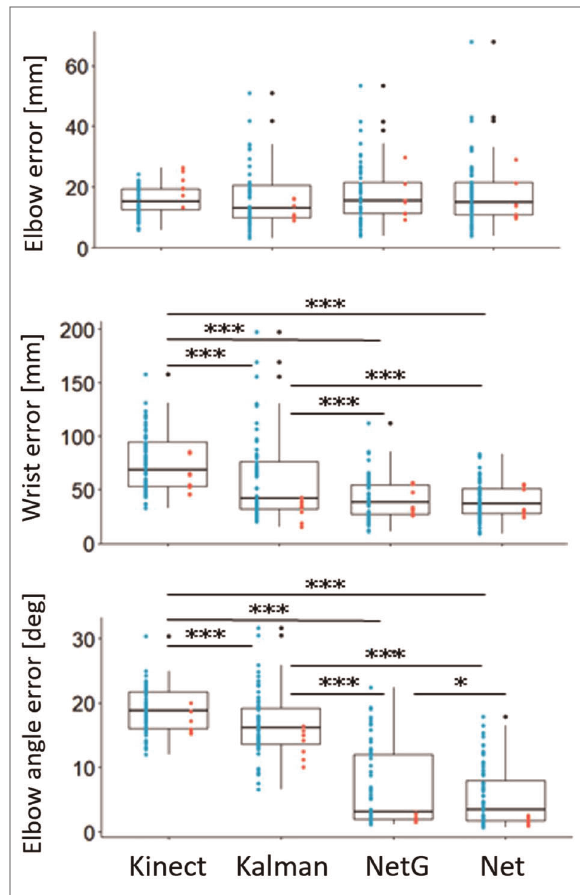
FIGURE 6 Boxplots and data points of the elbow joint absolute residual error (top), wrist joint absolute residual error (middle) and elbow angle absolute error (for the network trackers), and absolute residual error (for the Kalman fi lter) (bottom). Kinect: Kinect recording error, Kalman: Kalman fi lter error, NetG: network with goniometer input error, Net: network without goniometer input error. Black points represent outliers. Blue points represent data from the original position of the Kinect sensor. Red points represent data from the alternative position of the Kinect sensor. * p <0.05, *** p